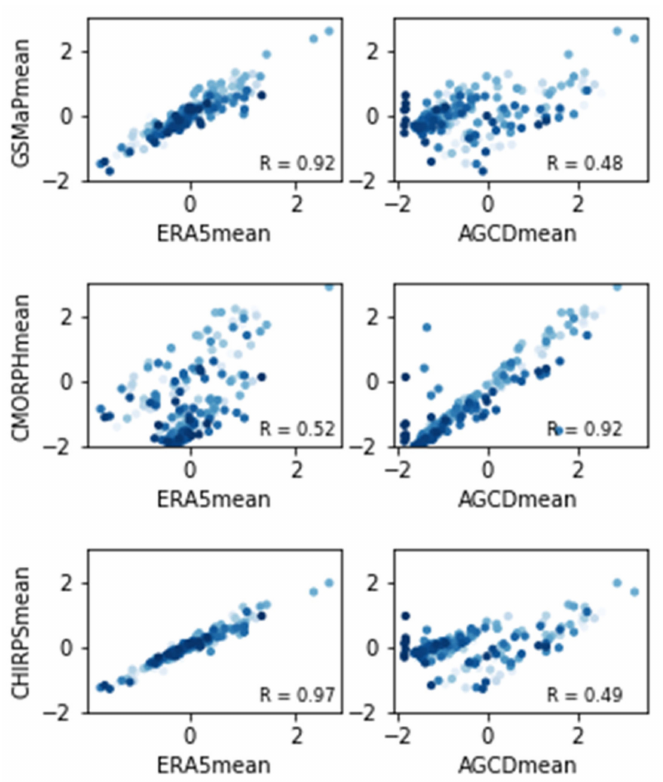
Figure 2. Scatterplot of monthly average precipitation anomalies across the study region for each SPE compared to ERA5 and AGCD. Units are in mm/day. The pale dots indicate months earlier in the study period and the dark dots represent months closer to the end of the study period.